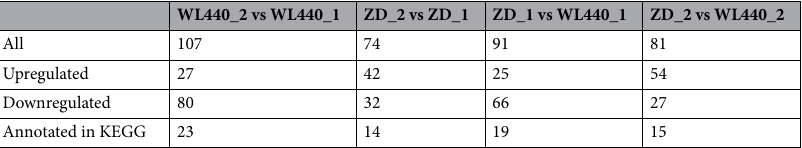
Table 1. Numbers of differential metabolites.